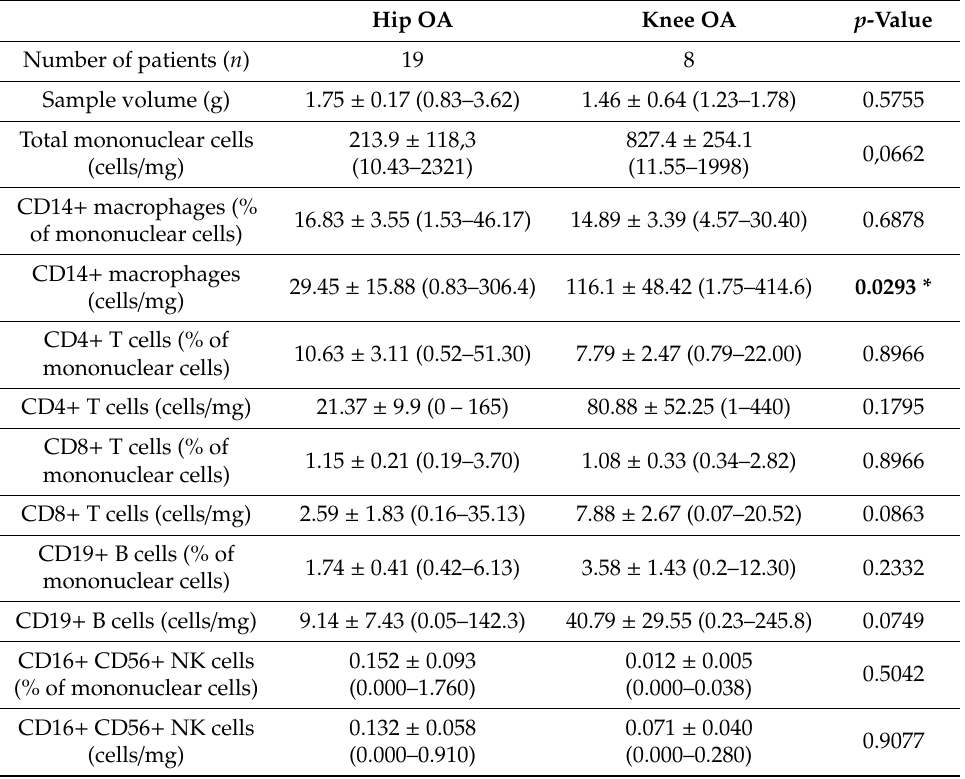
Table 2. Frequencies of mononuclear cells in synovial membrane of end-stage hip and knee osteoarthritis